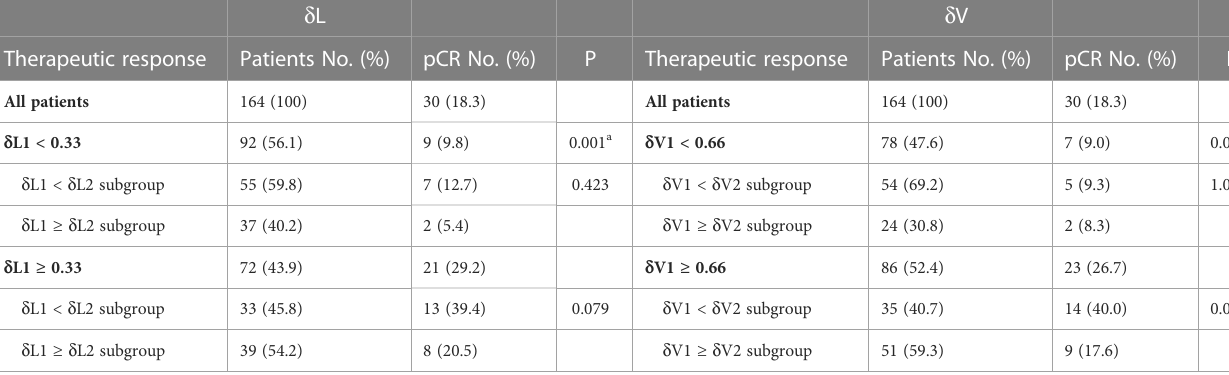
TABLE 3 Comparisons of pCR rates among different d L1 subgroups and d V1 subgroups. d L d V